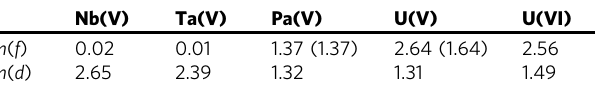
Table 5 Total metal valence d- and f -populations